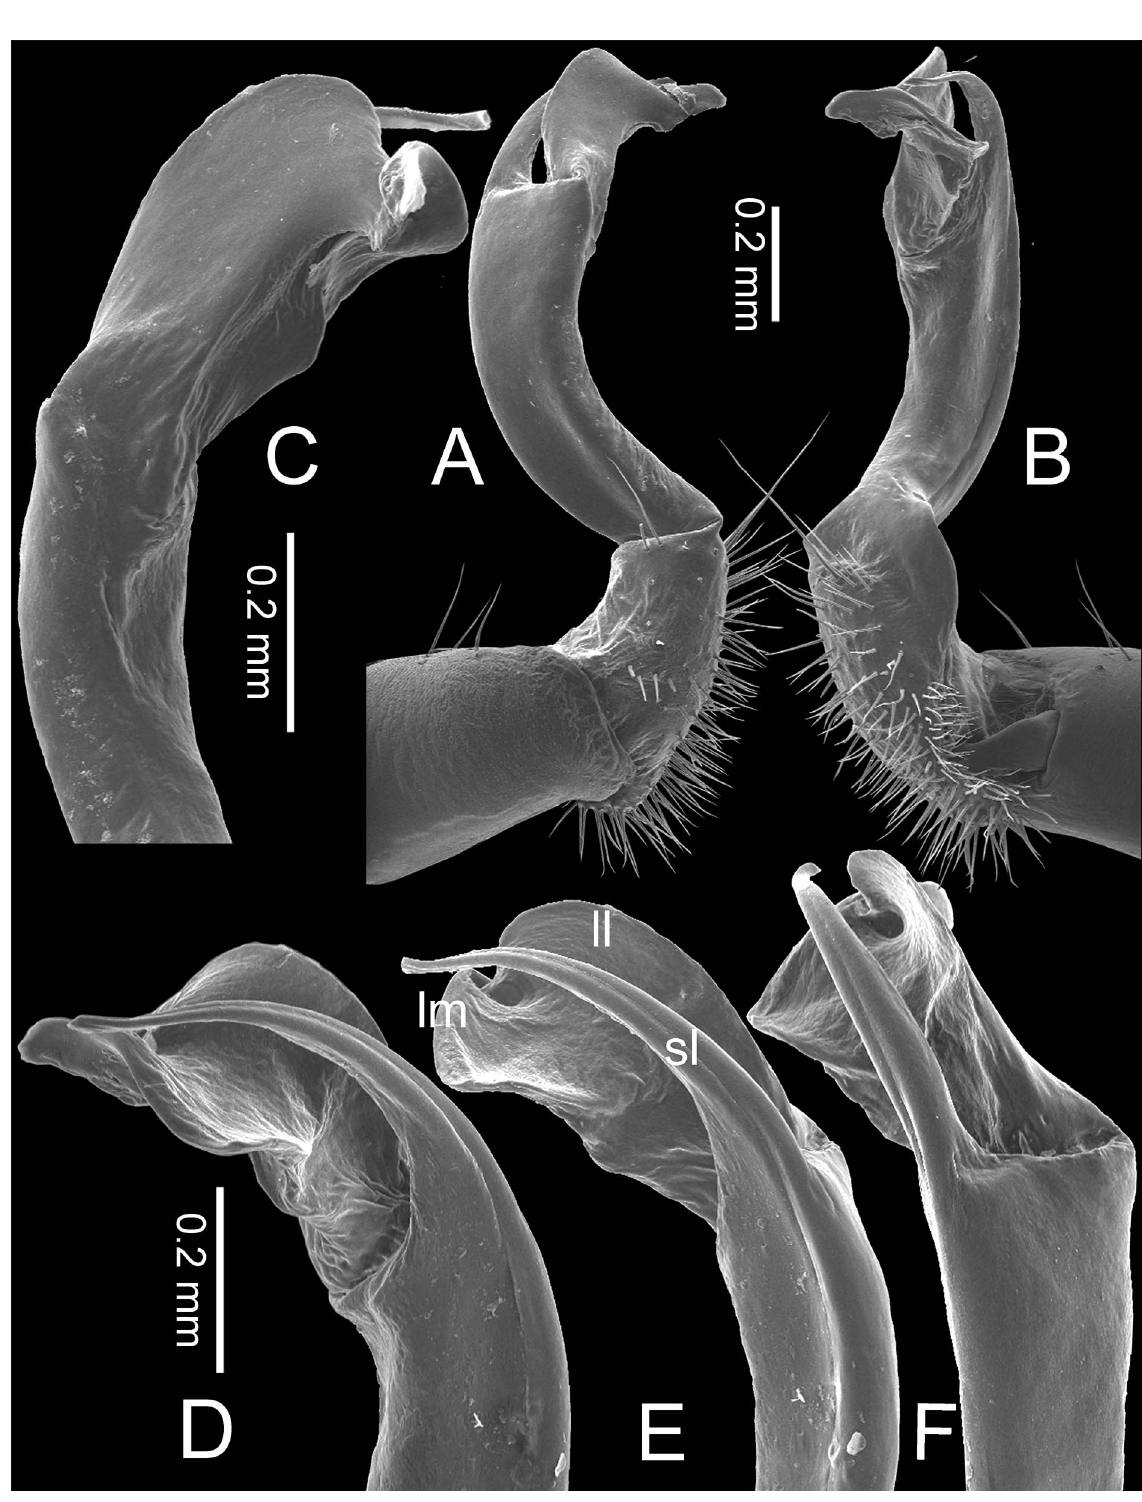
Fig. 23. Gigaxytes suratensis Srisonchai, Enghoff & Panha gen. et sp. nov . , ♂, paratype – right gonopod. A . Lateral view. B . Mesal view. C . Ventral view. D , F . Subdorsal view. E . Dorsal